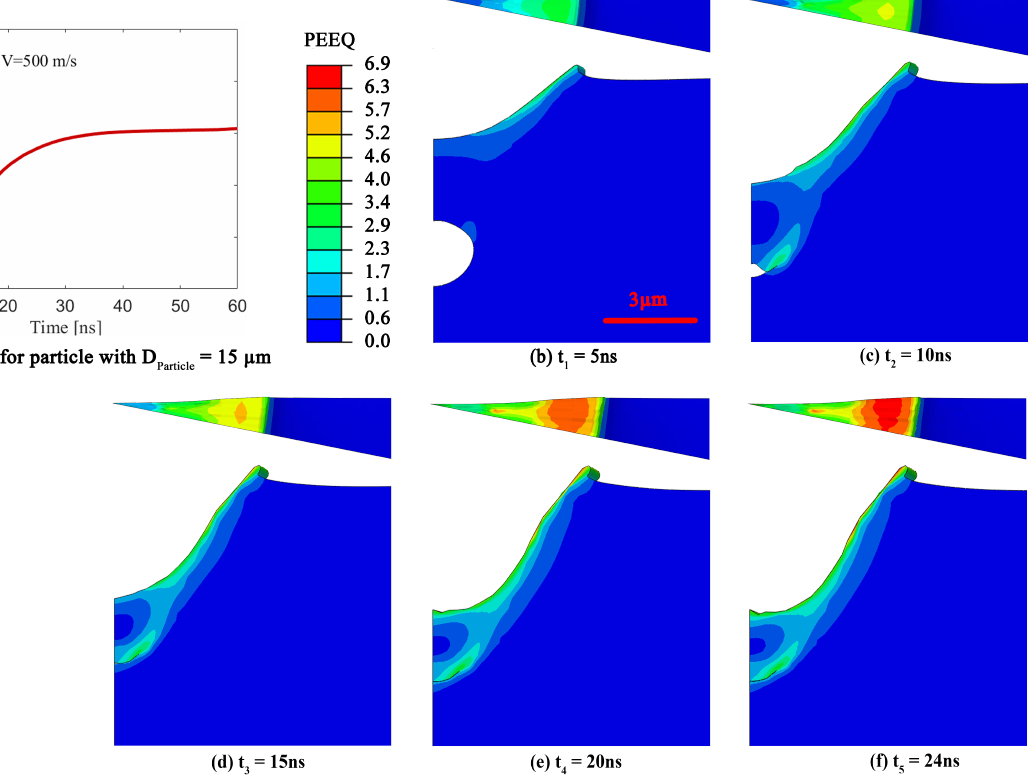
Figure 5. The time-resolved still frames showing pore morphology behavior and PEEQ values for a pore with D Pore = 4 µ m at a depth of 0.3 D Particle and V Impact = 500 m/s. ( a ) The average PEEQ value vs. time to determine the maximum PEEQ value which is 6. The top view and the side view of the substrate with a pore are demonstrated at a time range of ( b ) 5 ns, ( c ) 10 ns, ( d ) 15 ns, ( e ) 20 ns, and ( f ) 24 ns in order to show pore volume